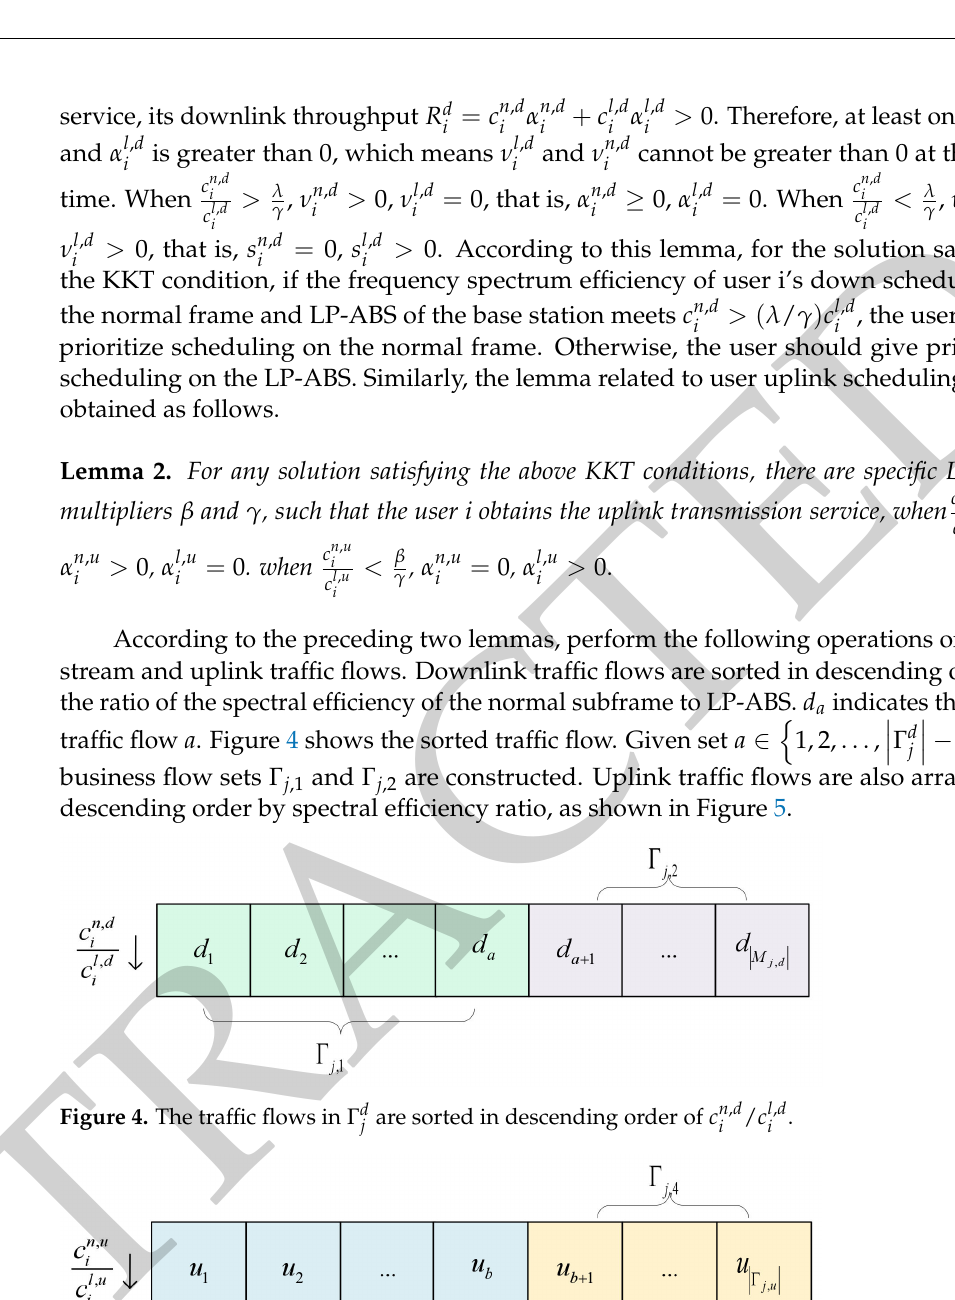
Figure 5. The traffic flows in Γ u